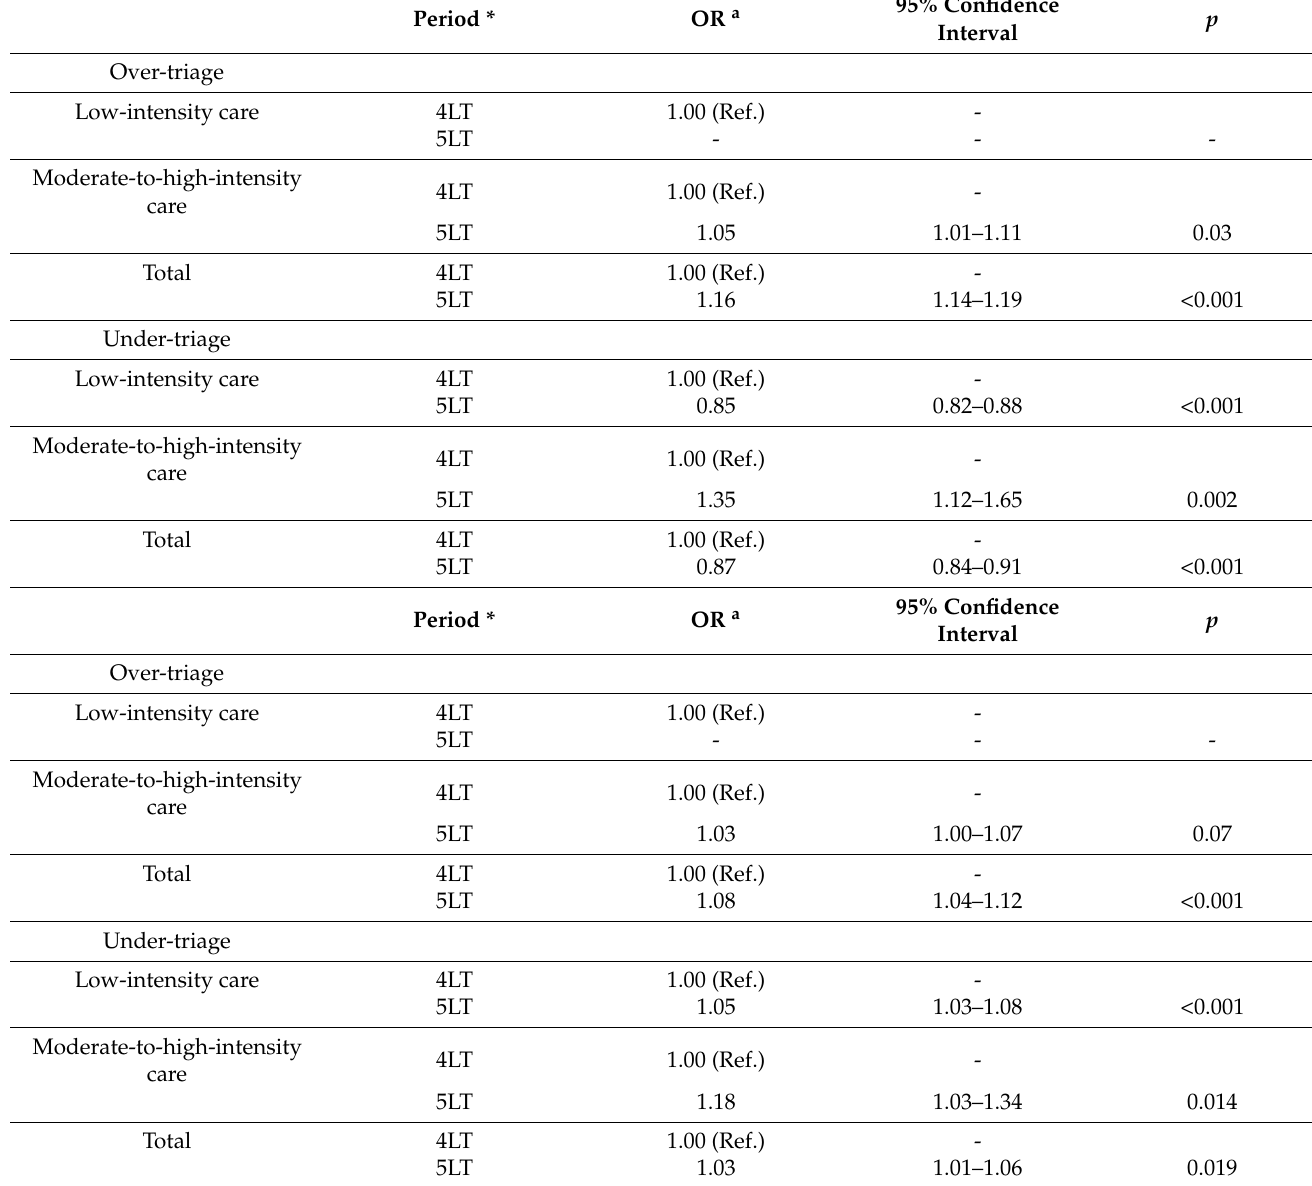
Table 3. Risk of UT and OT by